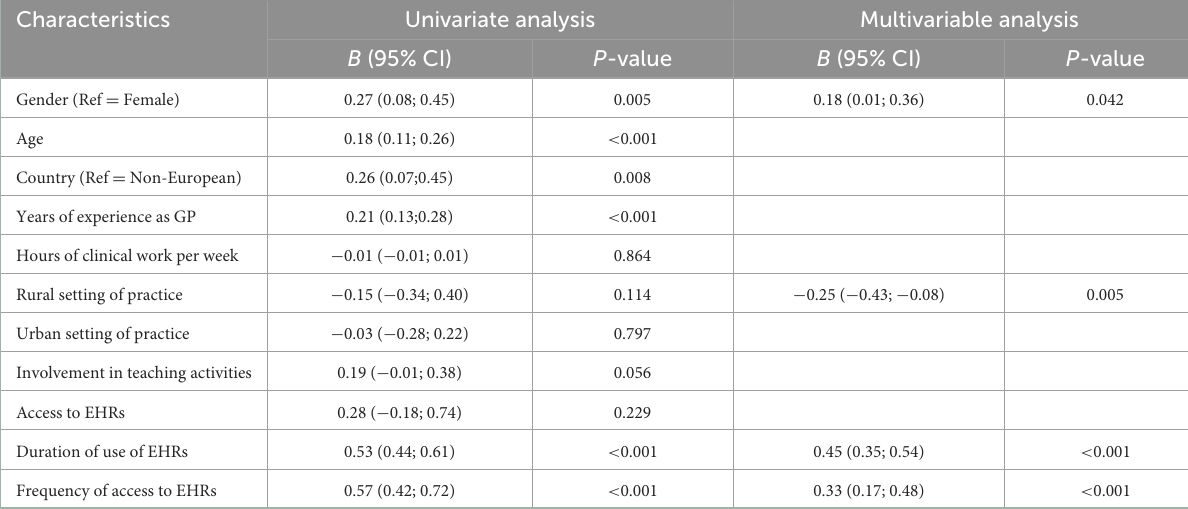
TABLE 2 Univariate and multivariable linear regression models to explain the digital maturity score.